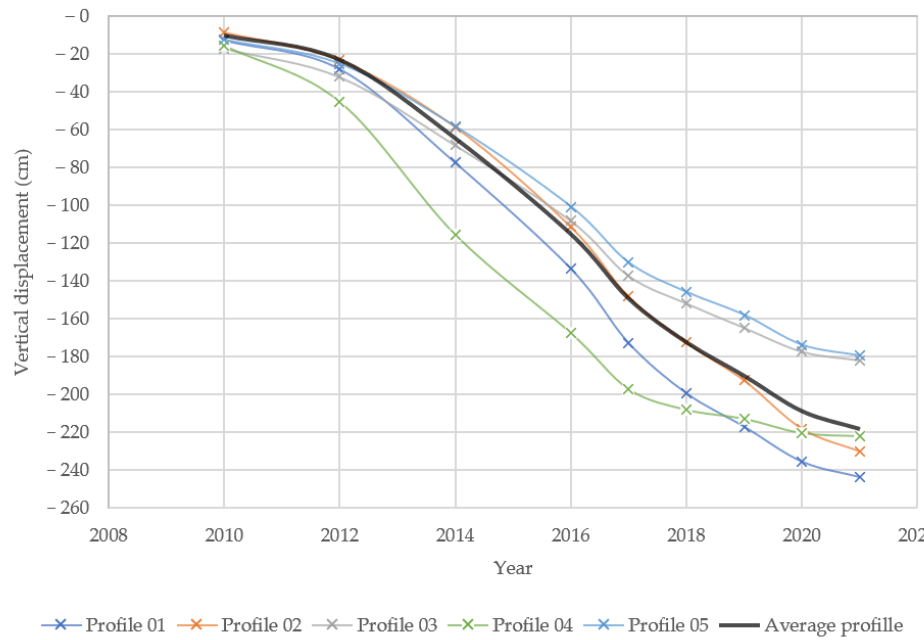
Figure 8. Maximum subsidence values of MP 03.